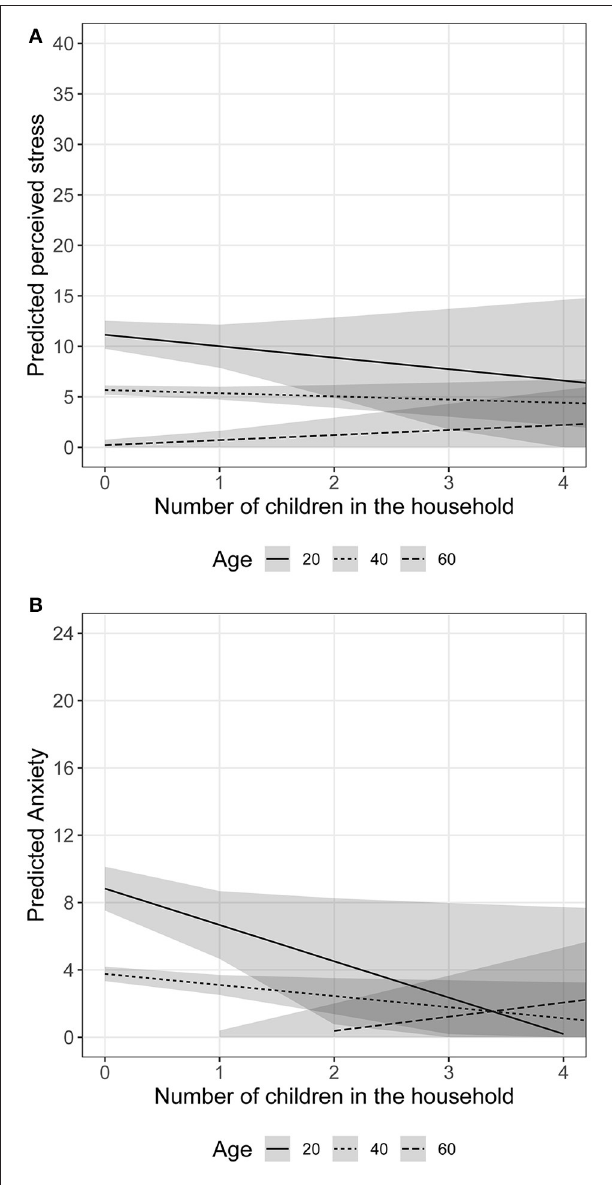
FIGURE 1 | Associations between perceived stress/anxiety levels and number of children in the household among women of different age groups. Shaded area = 95% confidence interval. (A) Perceived stress and number of children in household among different age groups. (B) Anxiety and number of children in household among different age